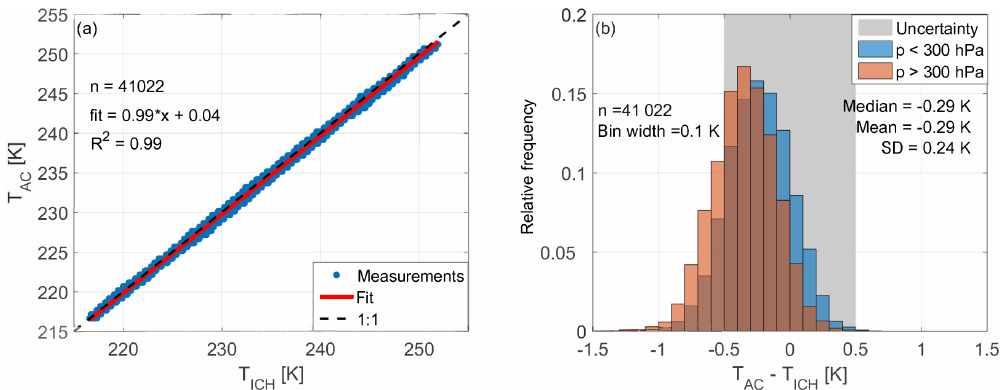
Figure 2. (a) Temperature correlation for all measurements below the pressure altitude 400hPa and (b) temperature bias of the IAGOS temperature instrument ( T ICH ) compared to a regularly quality-checked temperature sensor ( T AC ) from the research aircraft for seven flights during the AIRTOSS-ICE campaign in 2013. The grey area marks the total range of the total uncertainty for the IAGOS temperature obser- vations. The temperature bias was separated for measurements between 300 and 400hPa (orange) and 200 and 300hPa (blue) to highlight the shift to a smaller bias at lower pressure.